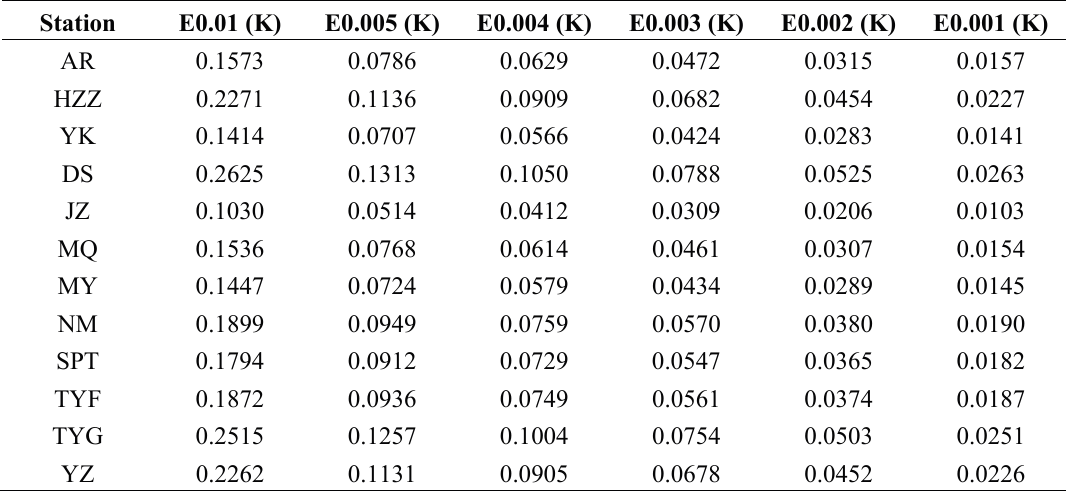
Table 5. Summary of the emissivity sensitivity analyses for all stations a